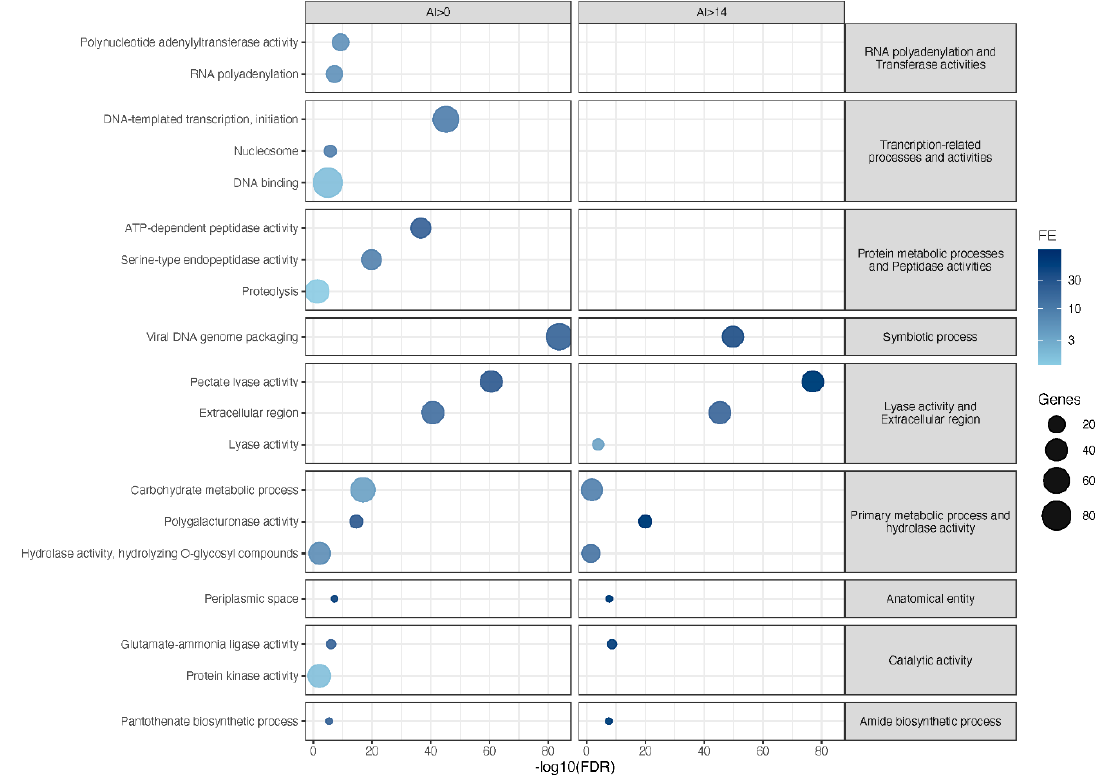
Figure 3. Enriched GO terms in proteins possibly acquired via horizontal transfers. Left side: possible HGT—AI > 0; right side: likely HGT—AI > 14. Only GO terms with FDR < 0.05 and at least four genes in the node are represented. Correlated terms are grouped together and represented by more general terms (right-side grey rectangles). Bubble sizes are according to the number of genes annotated with a specific GO term. Bubble positions are according to − log10 (FDR) values. The darkness of bubble colors is according to GO terms fold-enrichment (FE) values (see methods).